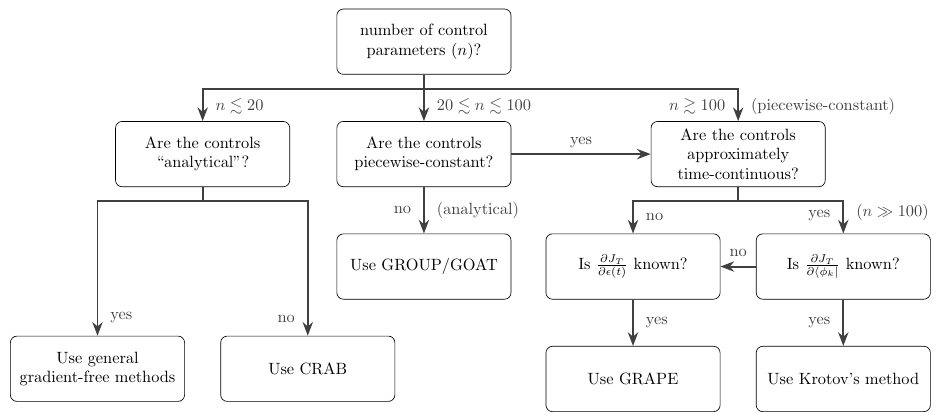
Figure 2: Decision tree for the choice of a numerical open-loop optimization method. The choice of control method is most directly associated with the number of control parameters ( n ). For “piecewise-constant controls”, the control parameters are the values of the control field in each time interval. For “analytical” controls, we assume that the control fields are described by a fixed analytical formula parametrized by the control parameters. The “non-analytical” controls for CRAB refer to the random choice of a fixed number of spectral components, where the control parameters are the coefficients for those spectral components. Each method in the diagram is meant to include all its variants, a multitude of gradient-free methods and e.g. DCRAB for CRAB, GRAPE-LBFGS and sequential / hybrid gradient-descent for GRAPE, and K-BFGS for Krotov’s method, see text for